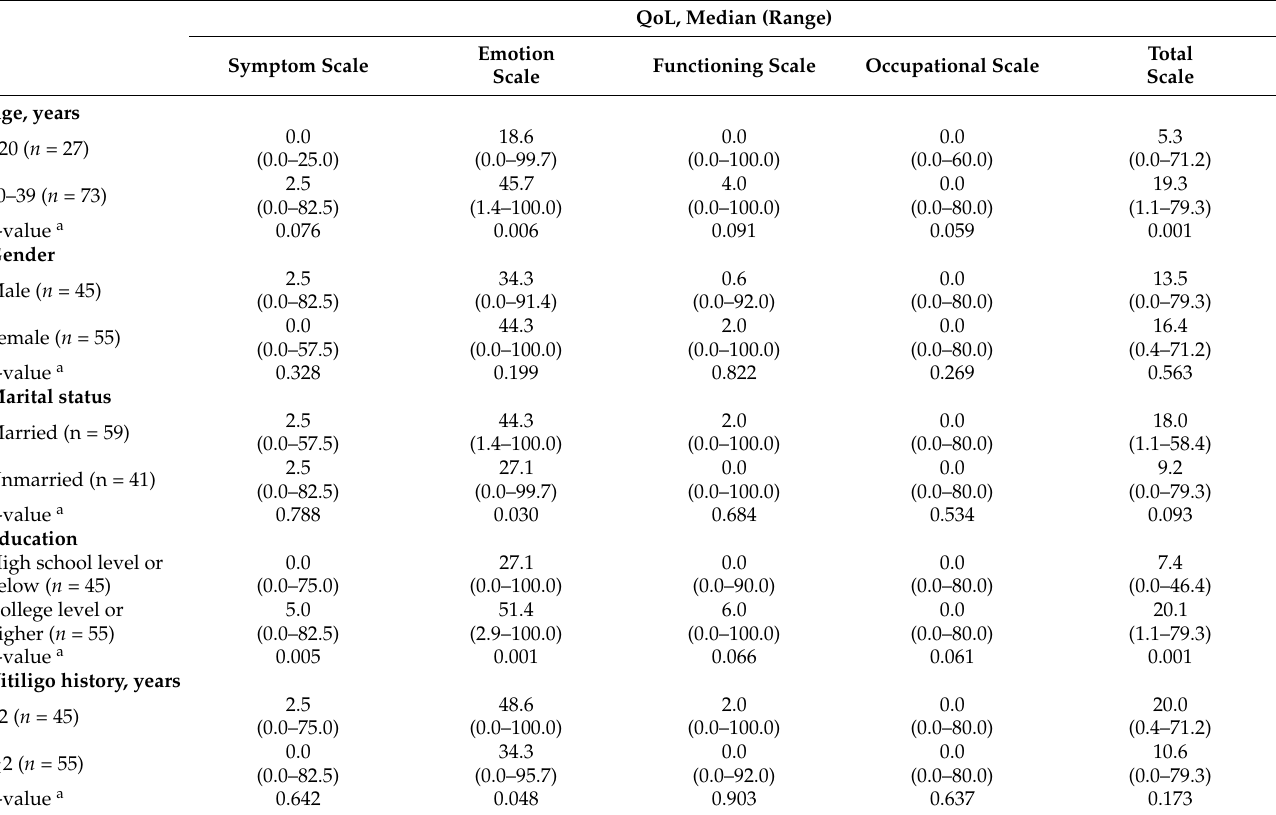
Table 2. Correlation of QoL in patients with vitiligo.